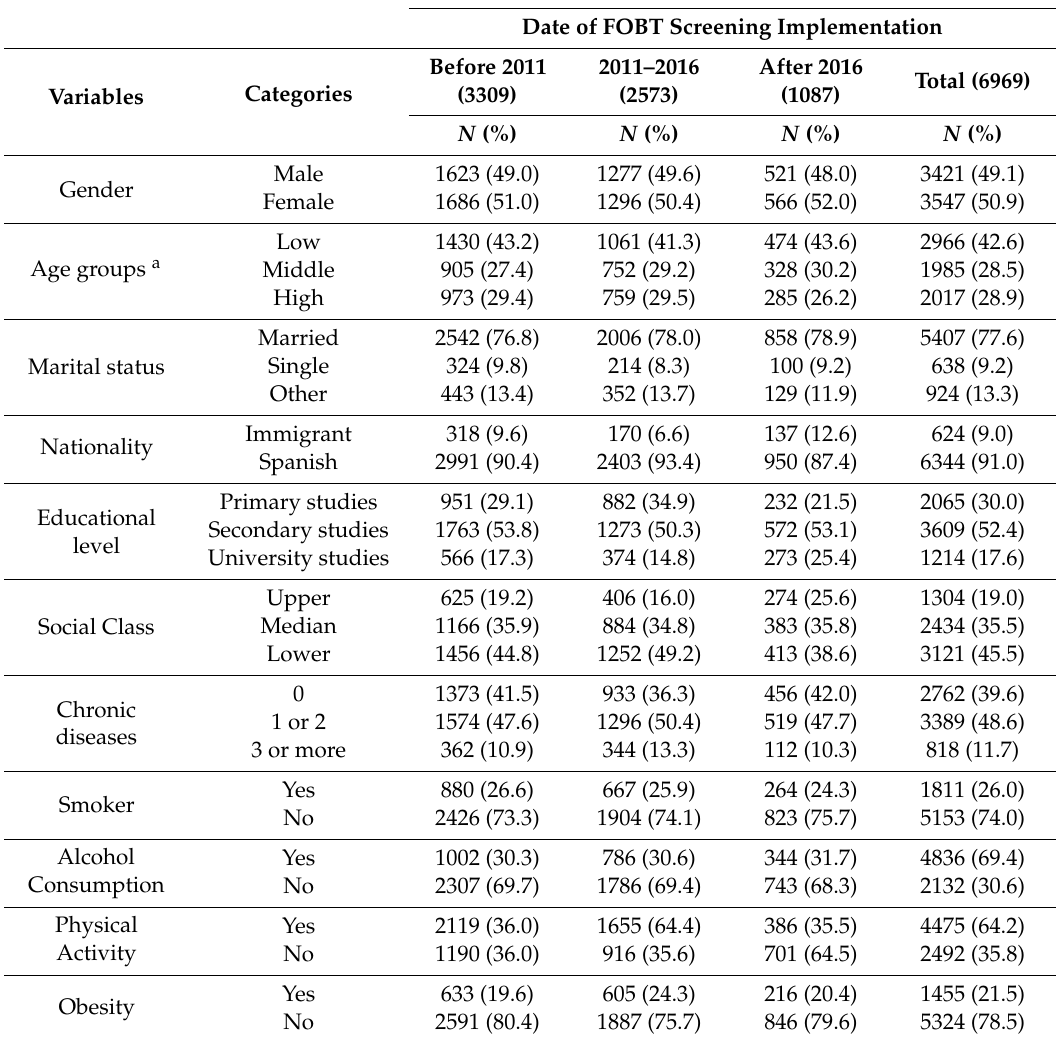
Table 2. Distribution of study populations for the fecal occult blood test screening by study variables according to the date CRC programs were implemented. Results from the Spanish National Health Survey